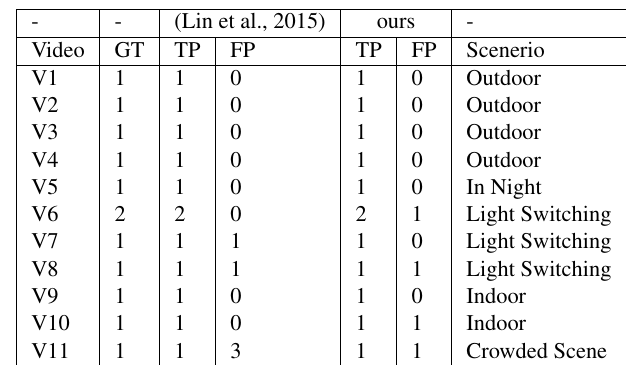
Table 1: Comparison of different methods on PETS2006 video dataset.